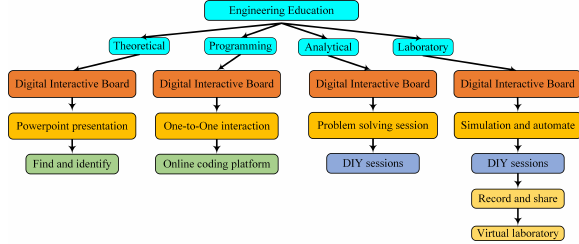
Fig. 2. Various ICT tools used in Engineering Education